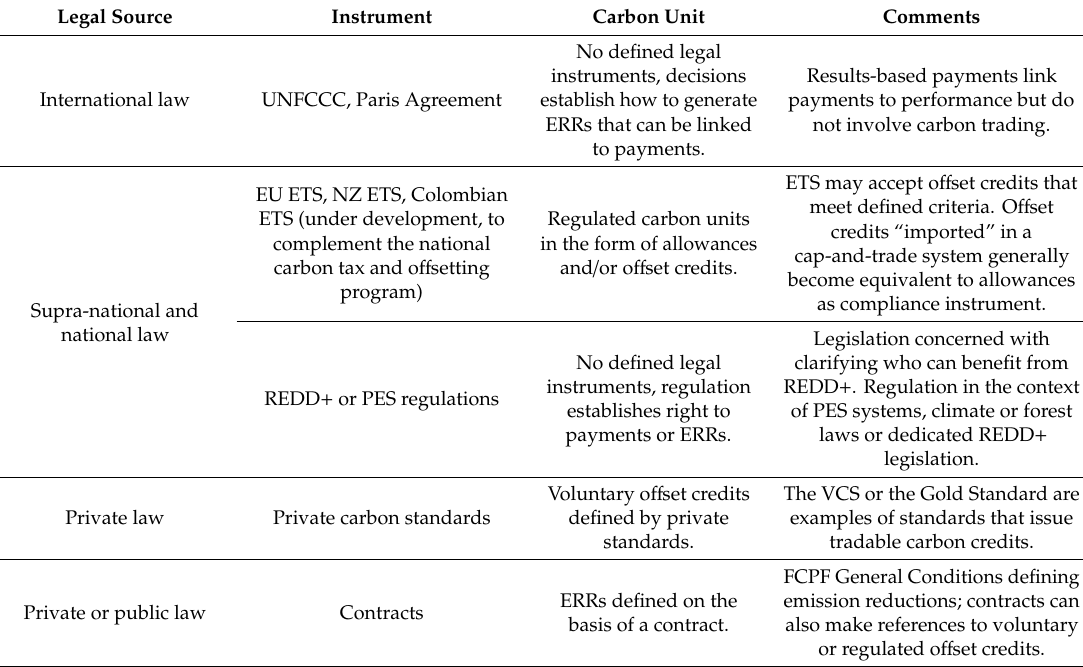
Table 3. Rights to carbon relevant to REDD +